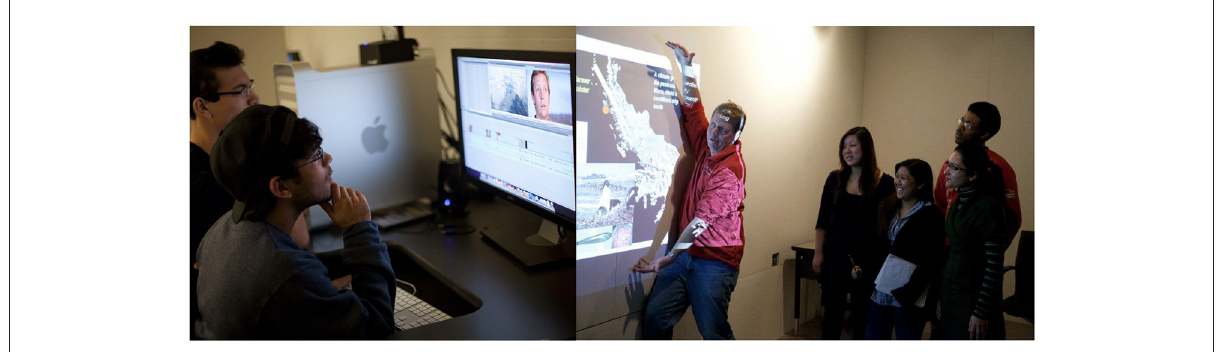
FIGURE3 Undergraduate students from a variety of majors edit video footage of scientists working in Antarctica (left) . Dr. Oscar Schofield provides climate science lectures to students who are helping to edit Antarctic Edge: 70 ◦ South (right) .